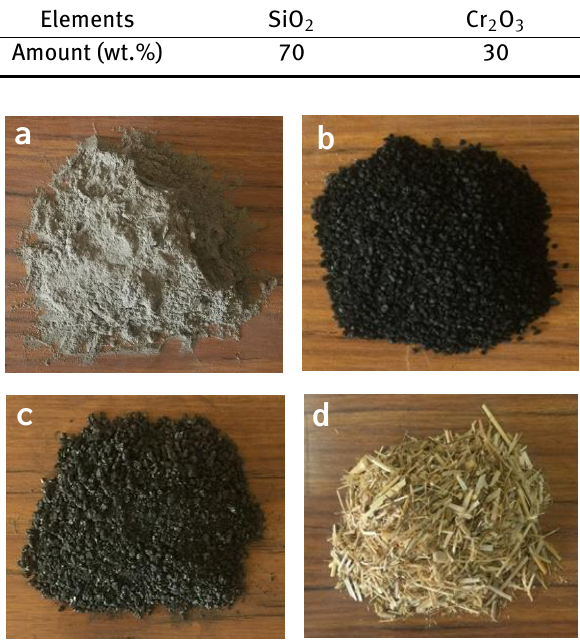
Figure 1: (a) MA, (b) NFC, (c) MCA and (d) SA.